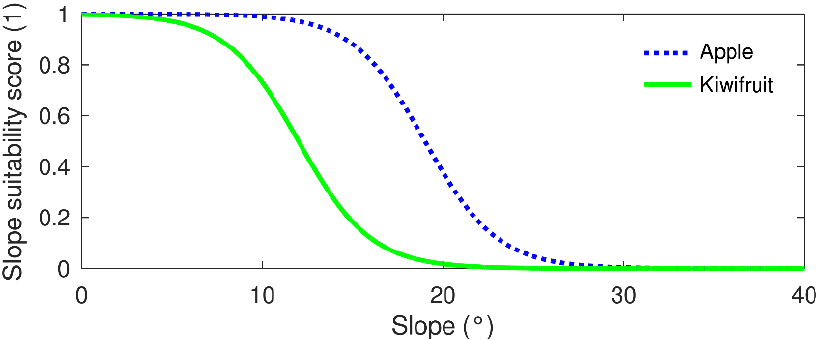
Figure 8 . Slope-suitability score assigned to slope for apple and kiwifruit, with higher scores being assigned to flatter slopes.